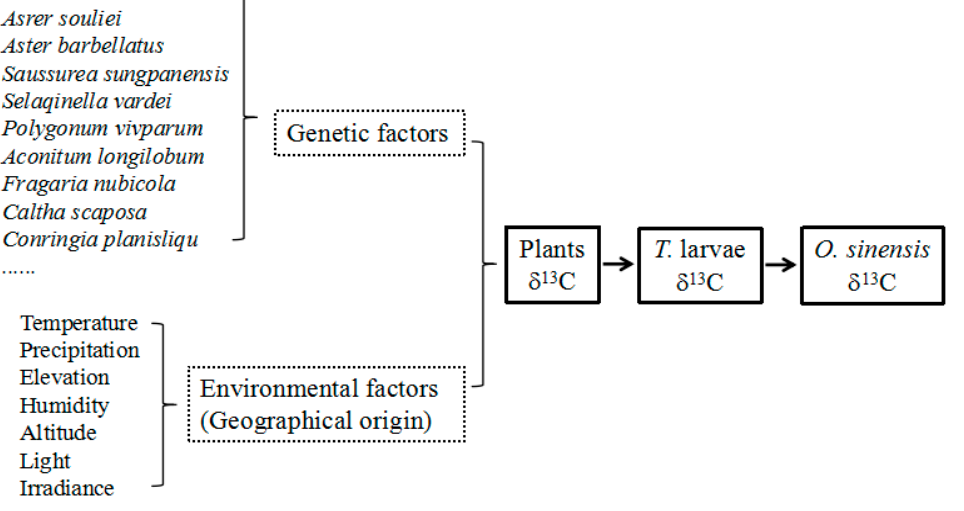
Figure 3. Impact factors on the δ 13 C values of O. sinensis.